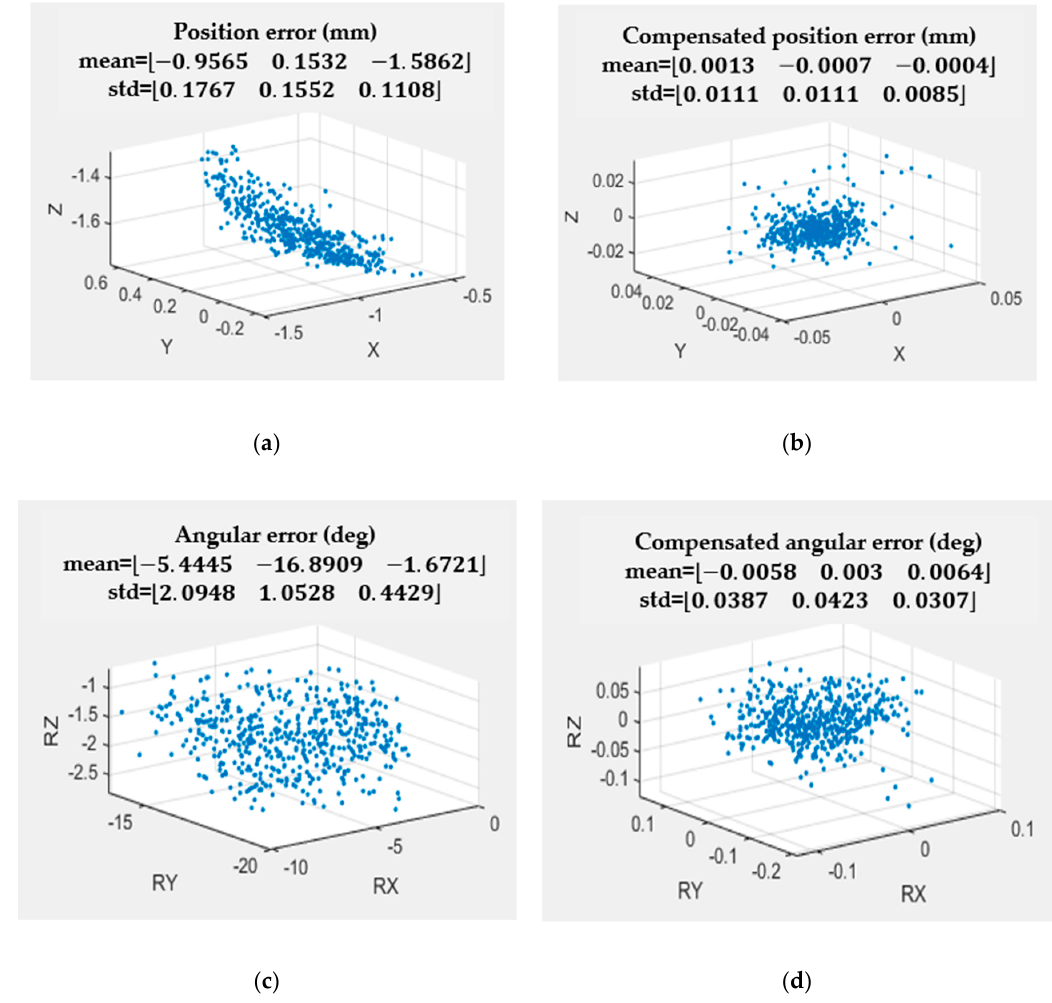
Figure 7. The error compensation results. ( a ) position error (mm) ( b ) compensated position error (mm) ( c ) angular error (deg) ( d ) compensated angular error (deg).